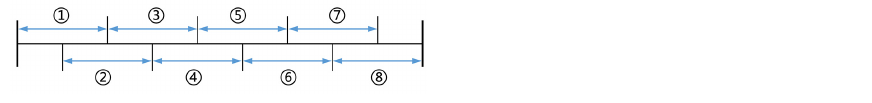
Figure 5. Schematic diagram of the staggered method (the length of each segment is ∆ T).